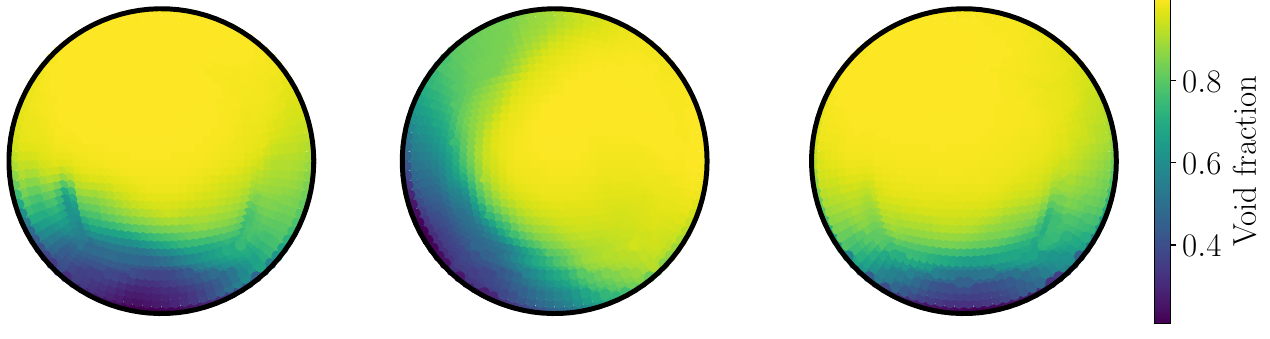
Figure 14. Average fields of void fraction in case c : section 4 ( left ); section B2 ( center ); section 5 ( right